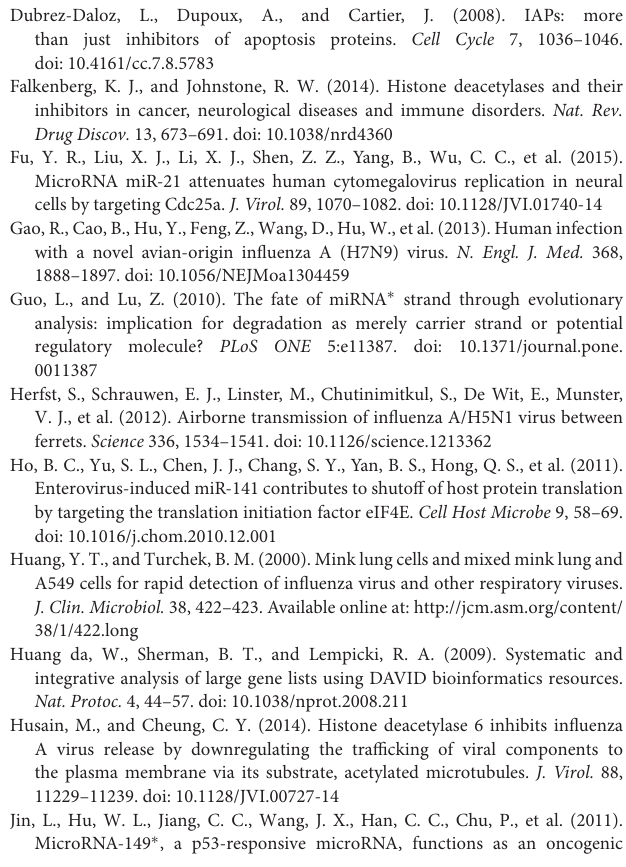
Figure S1 | Determination of CPE of A549 cells infected with IAV at different time points. A549 cells were infected with H1N1 and H5N1 at a MOI of 5 and CPE of